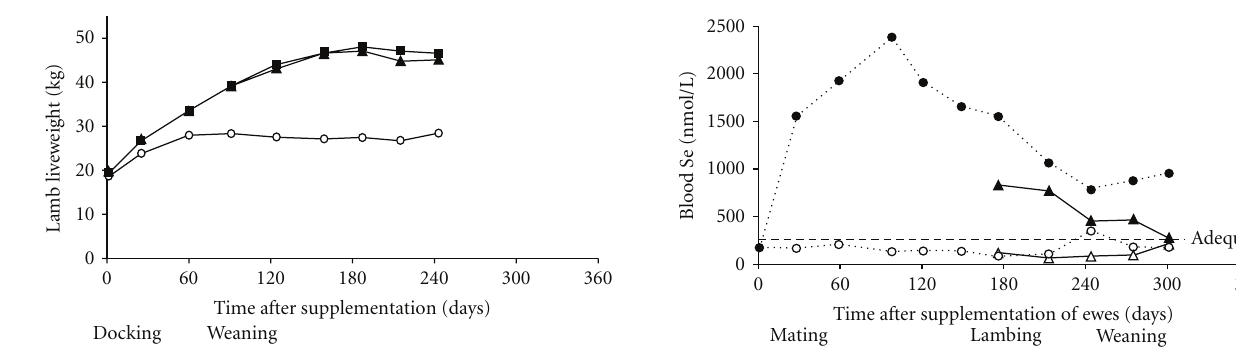
Figure 5: E ff ect of no treatment ( (cid:2) ) or subcutaneous injection of 60 mg Se as barium selenate (about 1 mg Se/kg LW) ( • ) administered to ewes 4 weeks prior to mating on blood Se concentrations of ewes ( (cid:2) , • ) and their lambs ( (cid:4) , (cid:2) ) from birth to weaning. Adequate Se status is indicated by blood Se > 250 nmol/L